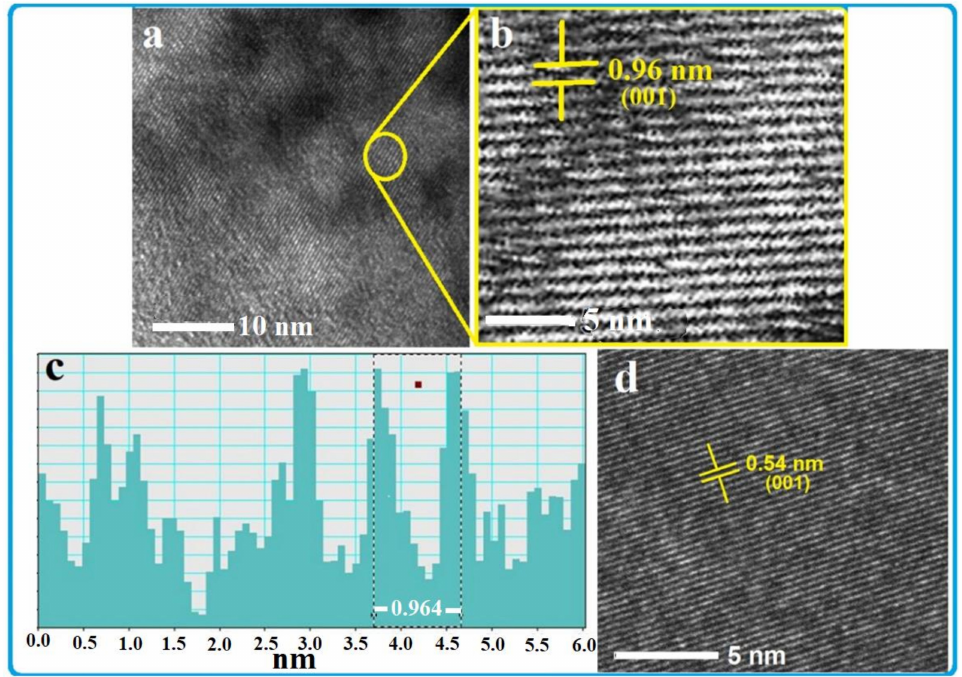
Figure 2. HRTEM images ( a , b ) of TiS 2 /organic superlattice and line scan ( c ) of the HRTEM image showing a d-spacing of ~9.64 Å. The HRTEM image presented in ( d ) is of a TiS 2 single